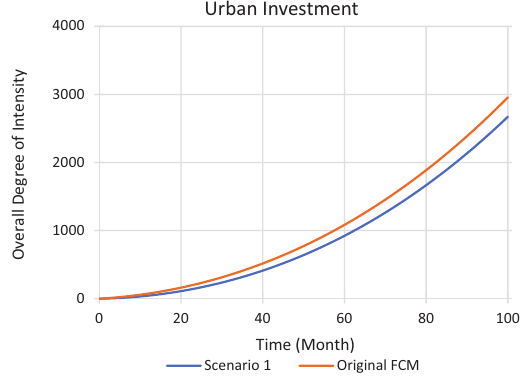
Figure 6. Impact of –0.50 change in each cluster on